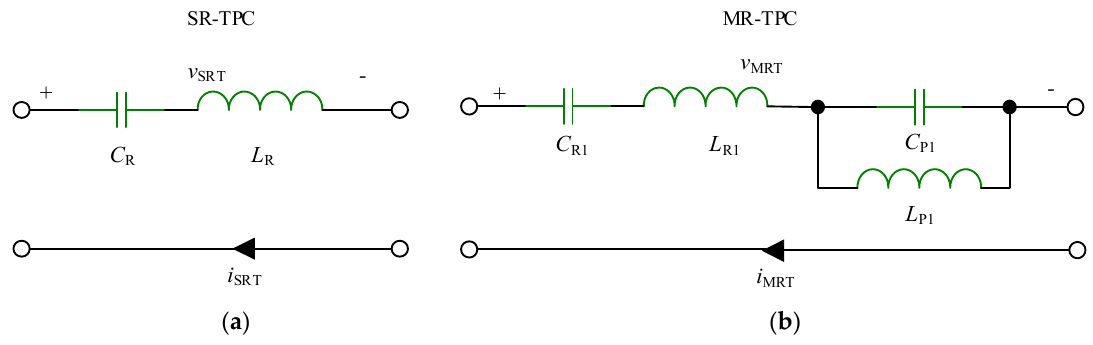
Figure 4. The comparison of resonant cavity structures ( a ) SR-TBC; ( b ) MR-TBC.